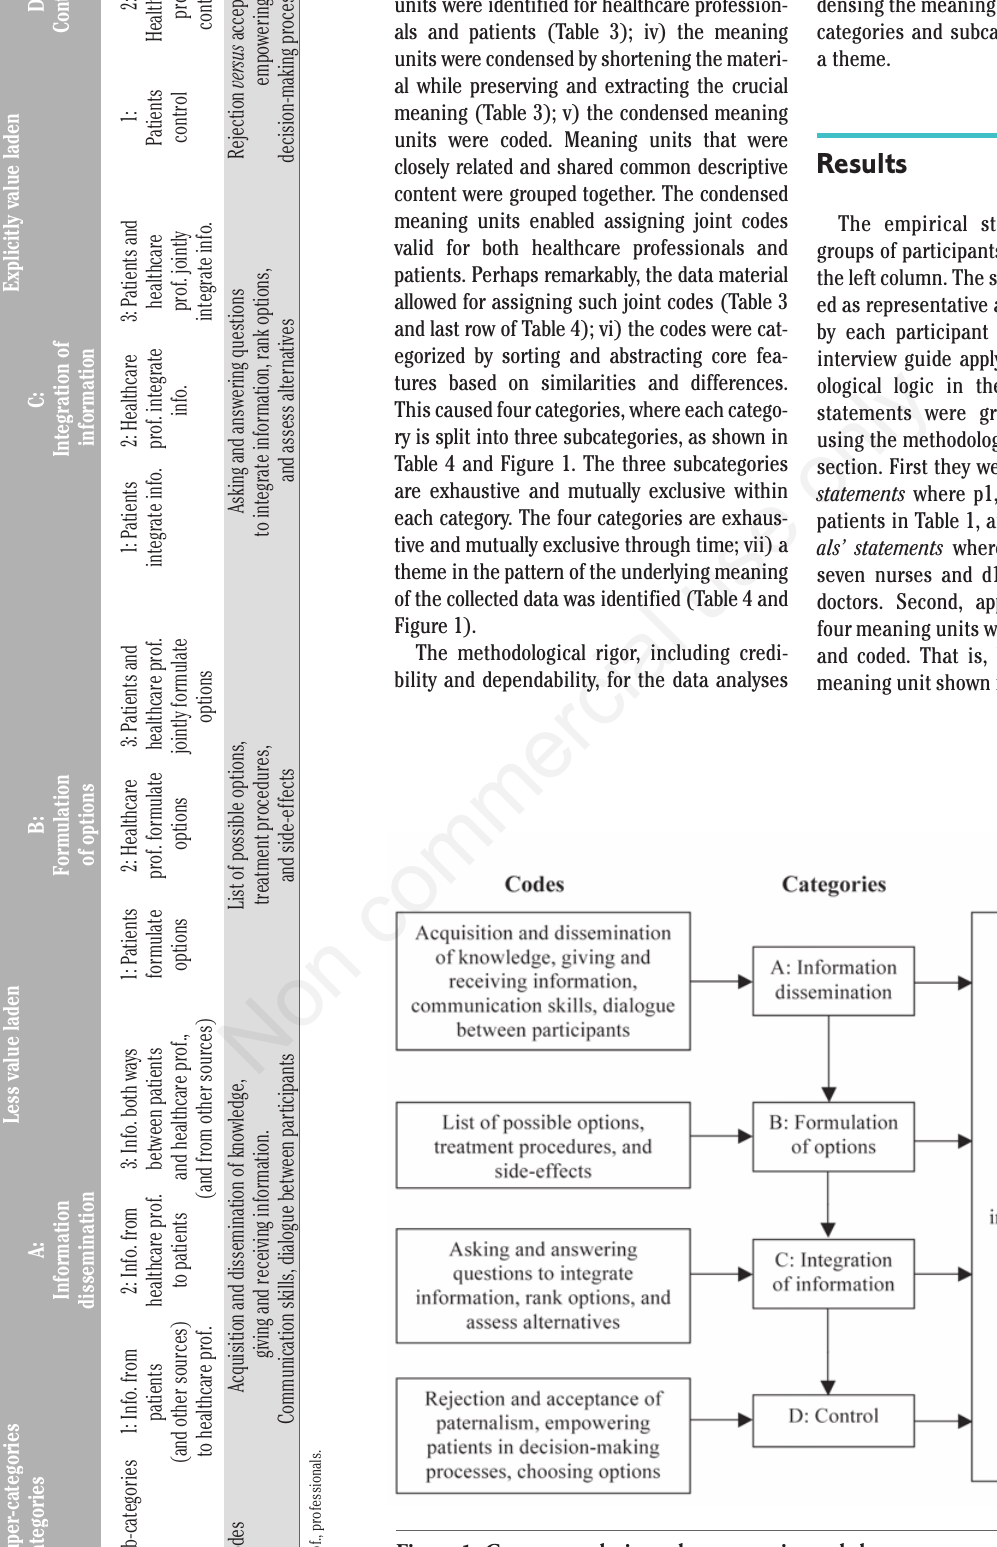
Figure 1. Content analysis: codes, categories and